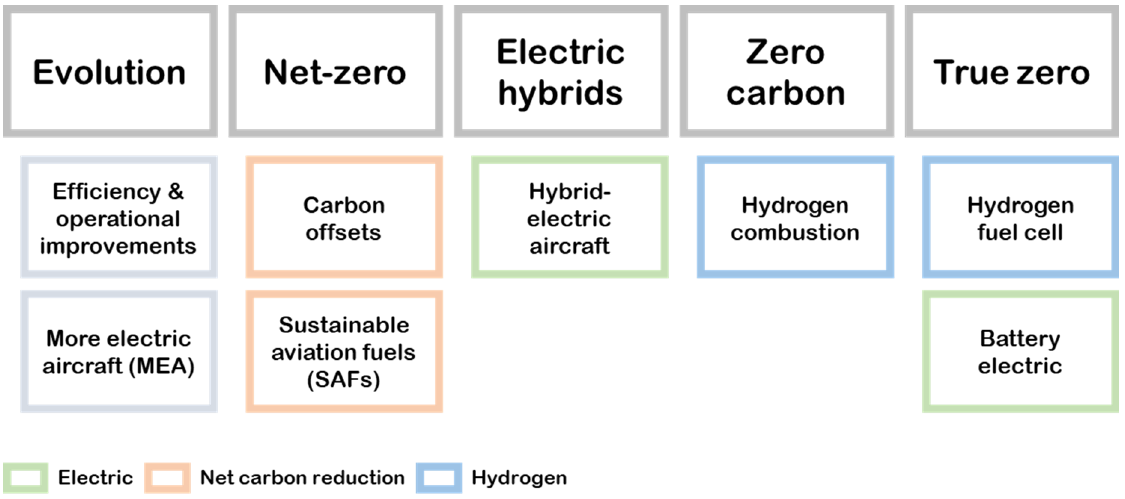
Figure 1. Aircraft classification according to carbon emissions [28].